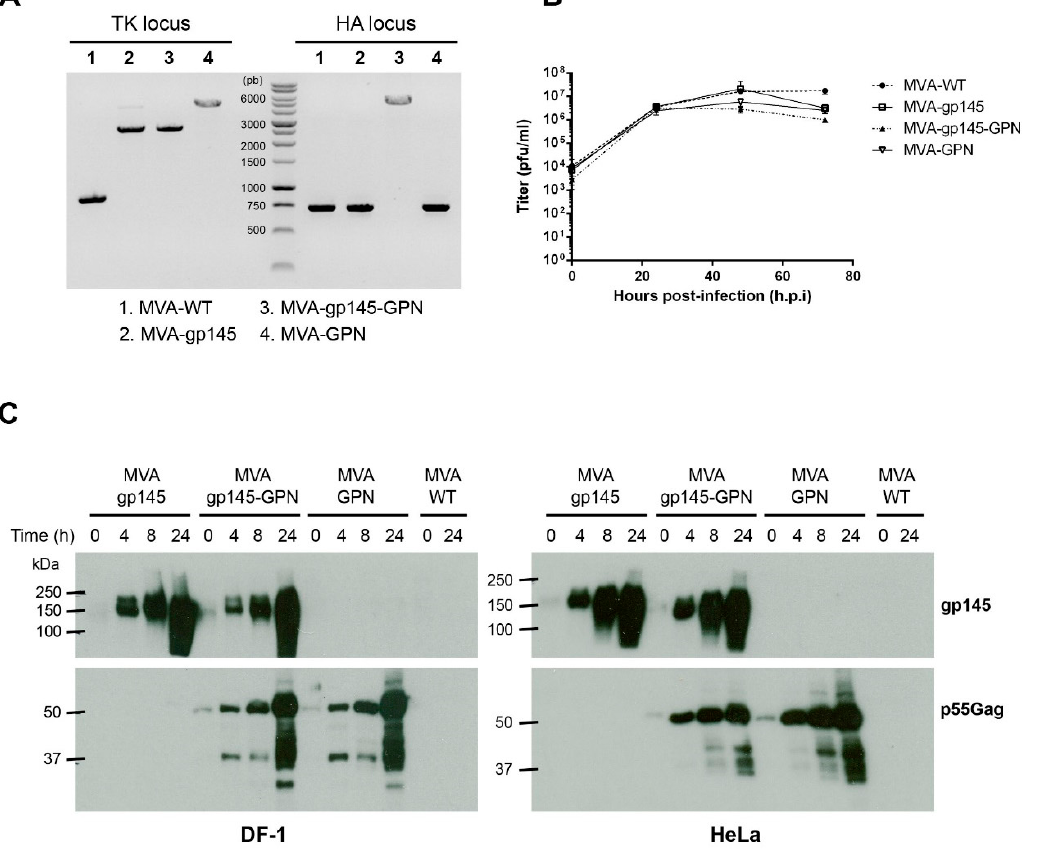
Figure 1. In vitro characterization of modified vaccinia virus Ankara (MVA)-based recombinant viruses expressing gp145 and/or Gag(ZM96)-Pol-Nef(CN54) (GPN) antigens. ( A ) Confirmation of HIV-1 gp145 and/or GPN insertion by PCR analysis. Viral DNA was extracted from DF-1 cells infected with MVA-WT, MVA-gp145, MVA-GPN or MVA-gp145- GPN at 5 pfu/cell. Primers thymidine kinase-L (TK-L) and TK-R spanning J2R (TK) flanking sequences or primers HA-MVA and HA-II spanning A56R (haemagglutinin (HA)) flanking sequences were used for PCR analysis of TK or HA loci, respectively. In parental MVA, a